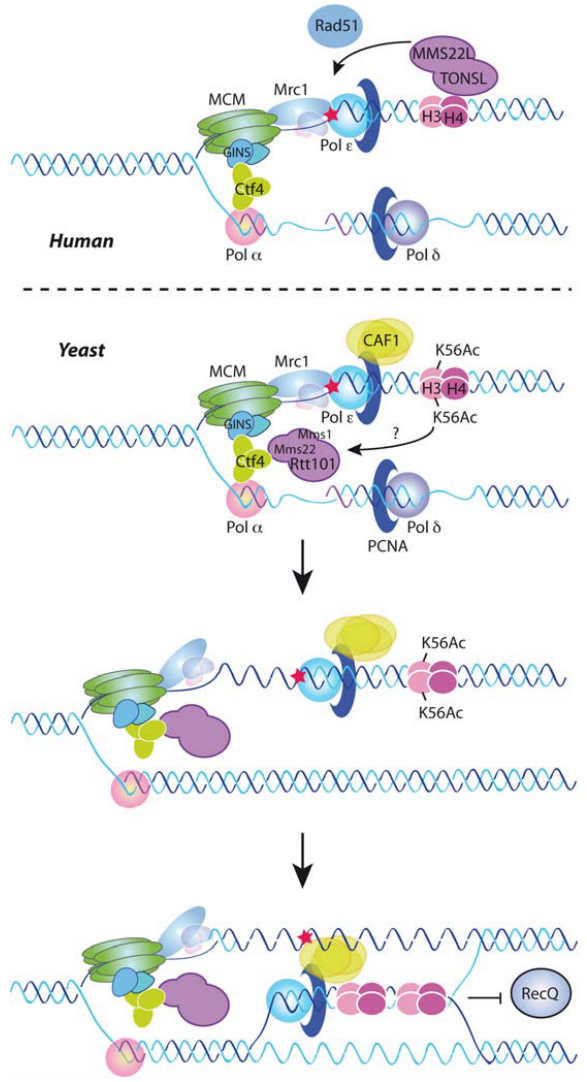
Figure 3. DNA damage tolerance by chromatin assembly. Encounter of a replication fork with